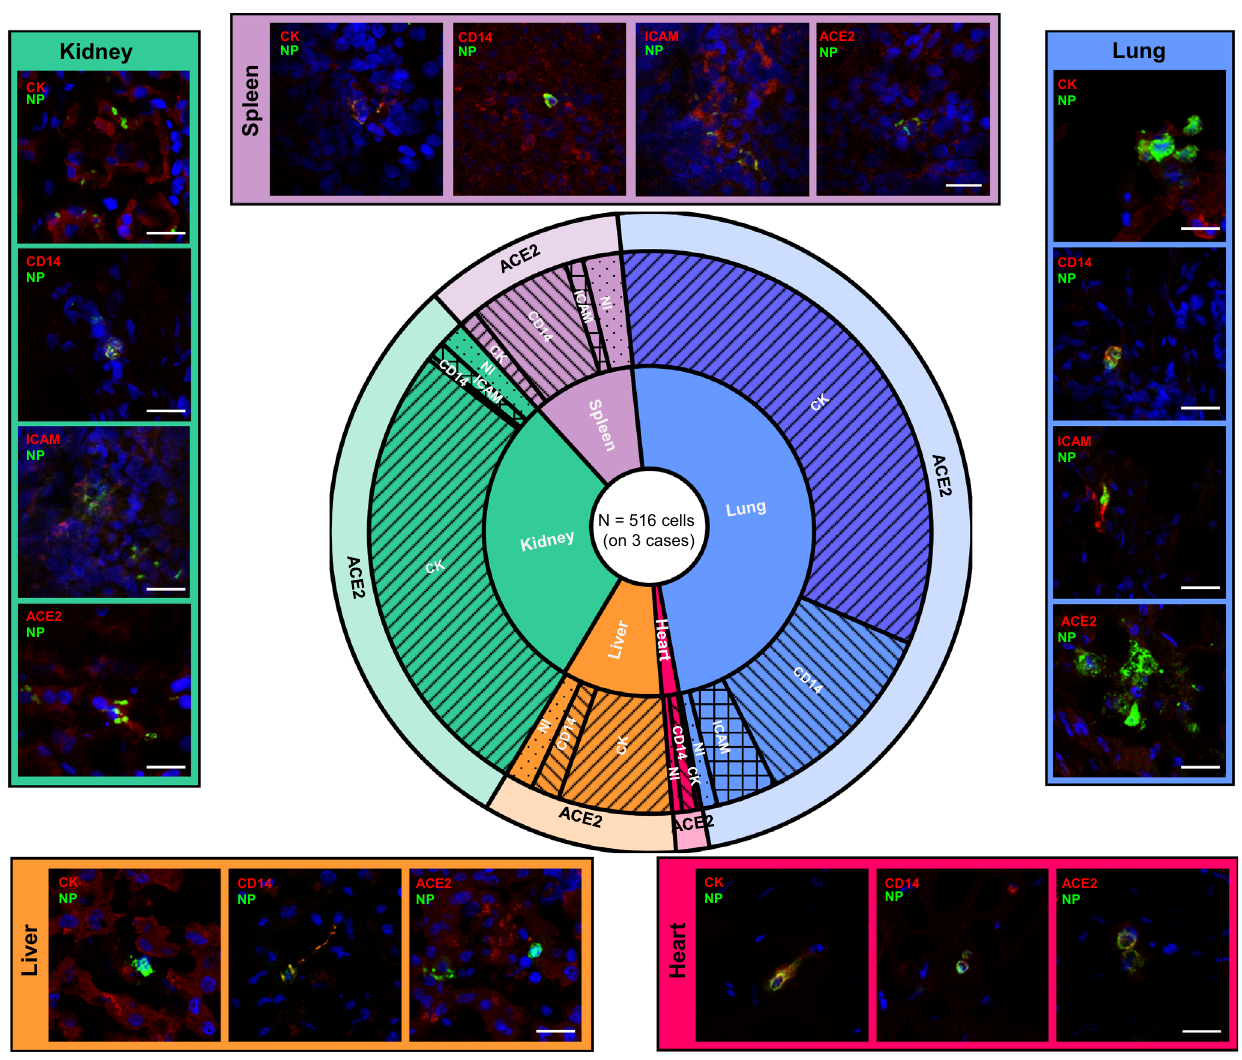
Fig. 2 Delineation of SARS-CoV-2 NP-positive cells and total viral burden from postmortem biopsies, by tissue type. A total of 516 SARS-CoV-2 nucleocapsid protein (NP)-positive cells were evaluated for marker expression (123 for ACE2, 133 for cytokeratin [CK], 136 for CD14, and 120 for ICAM) across different organs of three cases with viral dissemination (case 06, 07, and 13). The fi rst level of the sunburst chart represents the distribution of SARS-CoV-2 NP-positive cells across different organs (blue = lung, red = heart, brown = liver, green = kidney, purple = spleen). The second level of the sunburst chart depicts the percentage of cell types positive for SARS-CoV-2 NP per organ (forward slash = cytokeratin [CK], backward slash = CD14, crosshatch = ICAM, dotted = not identi fi ed [NI]), and the third level shows co-localization data with ACE2 (long and short form). Source data are provided as a Source Data fi le. Representative confocal images are grouped per organ (different colors) at the outer edges. Scale bars represent 25 µ